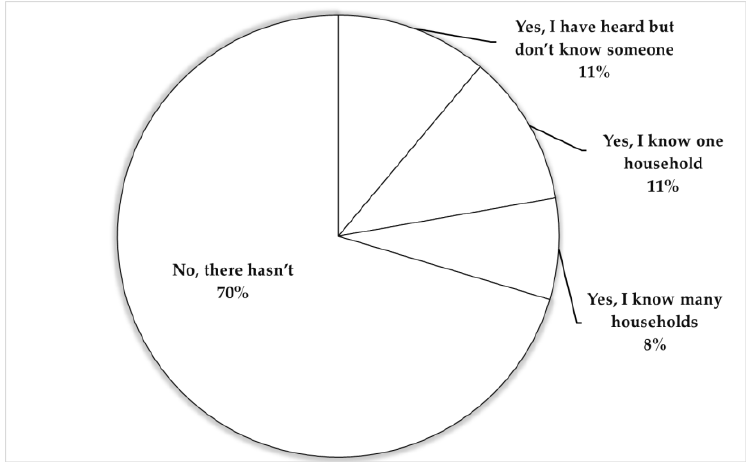
Figure 5. % of respondents who knew households moved out of the area. Source: survey, May, 2019.